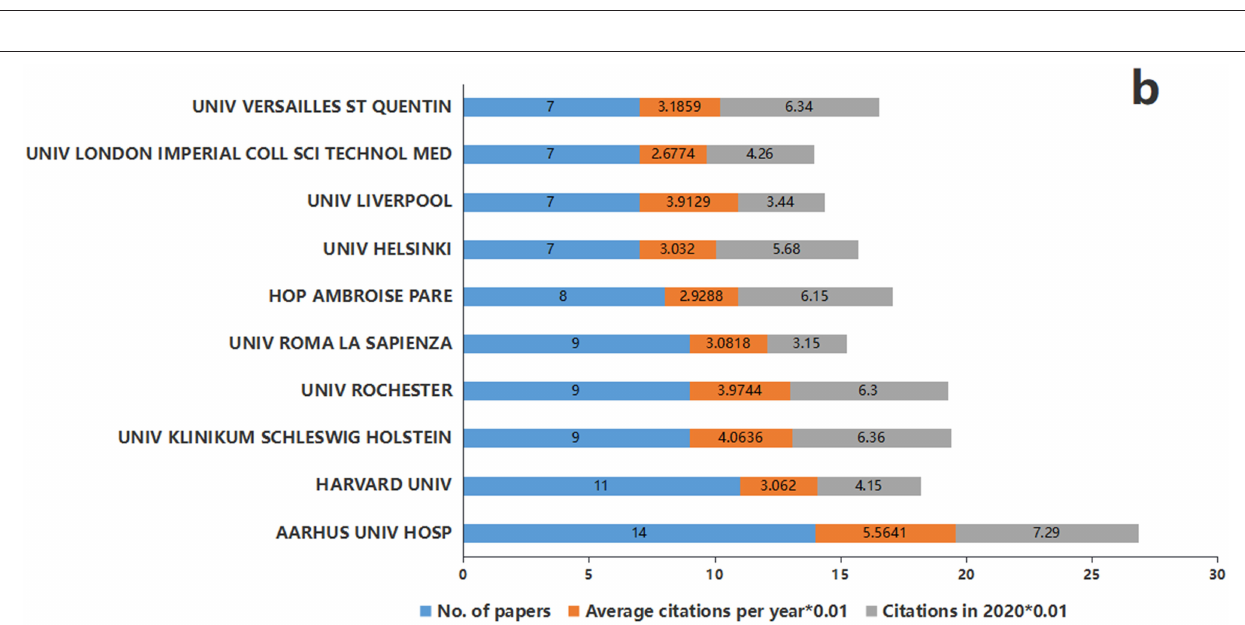
FIGURE 4 | The heat map showing the distribution of the top 100 most-cited papers in world.